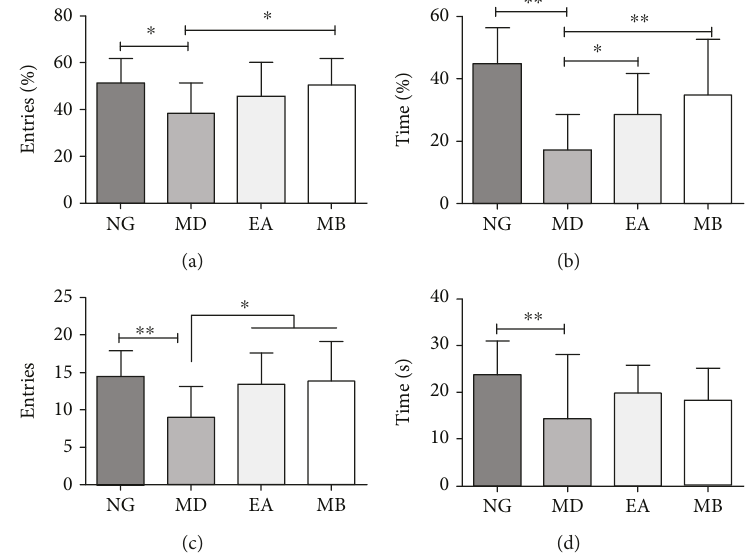
Figure 4: The anxiety-like behavior in elevated plus maze (EPM) and open fi eld test (OFT). Percentage of the entries into the open arms (a) and time spent in the open arms (b) in the EPM test. The accumulative time of entering the central area (c) and spent in the central area (d) in the OFT. NG: normal group; MD: model group; EA: electroacupuncture group; MB: moxibustion group ( ∗ P < 0 05 vs. MD